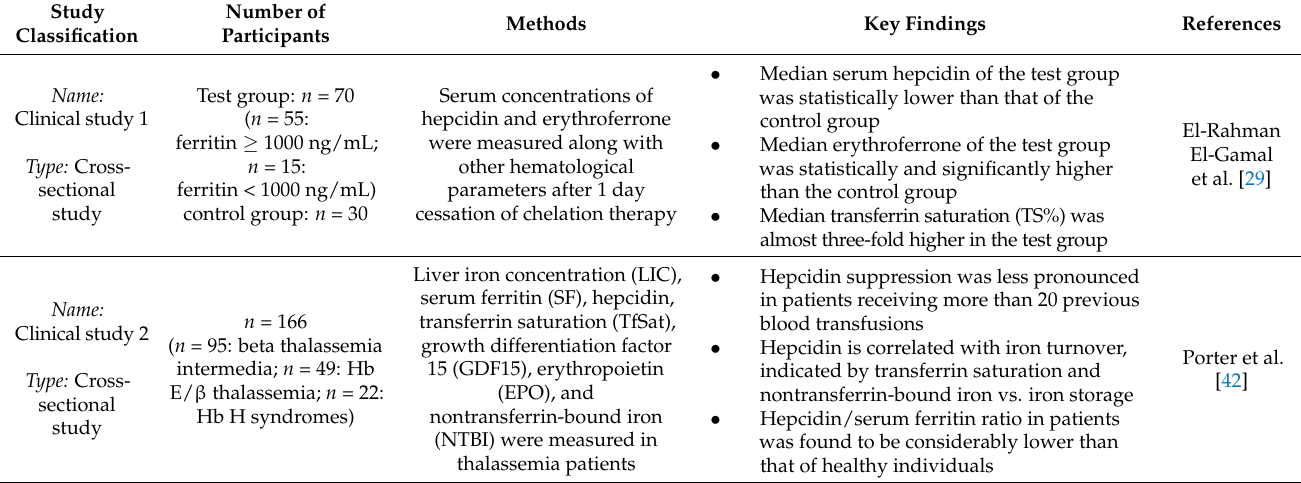
Table 1. Summary of clinical studies on the influence of hepcidin and erythroferrone in patients with beta